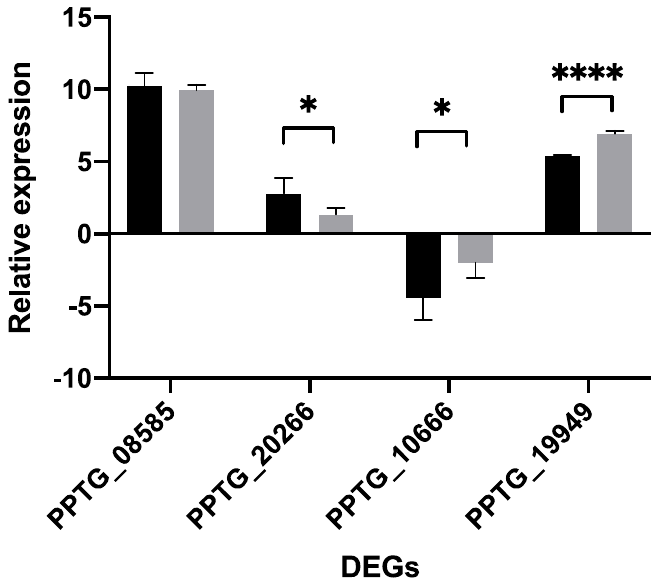
Figure 1. qRT-PCR validation of the DEGs identified in P. nicotianae by RNAseq analysis. Difference in relative gene expression between groups was determined using t -test in Prism 8. Significance is indicated using * for p value < 0.05, **** for p value < 0.0001. Genes PPTG_08585 and PPTG_20266 showed a lower relative expression in P. nicotianae when infecting K 326 Wz/Wz compared to infecting Hicks. Genes PPTG_10666 and PPTG_19949 showed a higher relative expression in P. nicotianae when infecting K 326 Wz/Wz compared to infecting Hicks. The expression of the genes was normalized to Ubc and WS21 as two internal